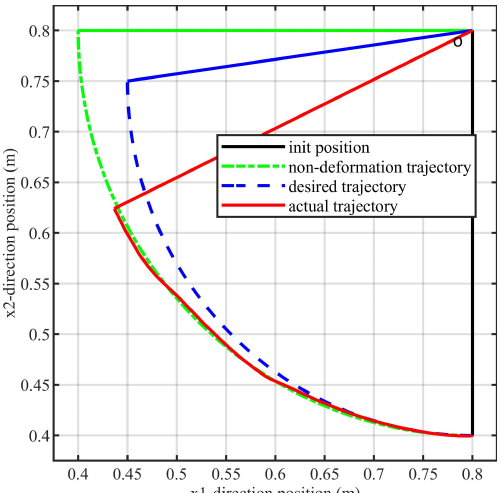
Figure 17. Different perspectives of the KUKA IIWA. The robot needs to open the door while the end effector remains parallel to the door. ( a ) Perspective from the side. ( b ) Perspective from the above.